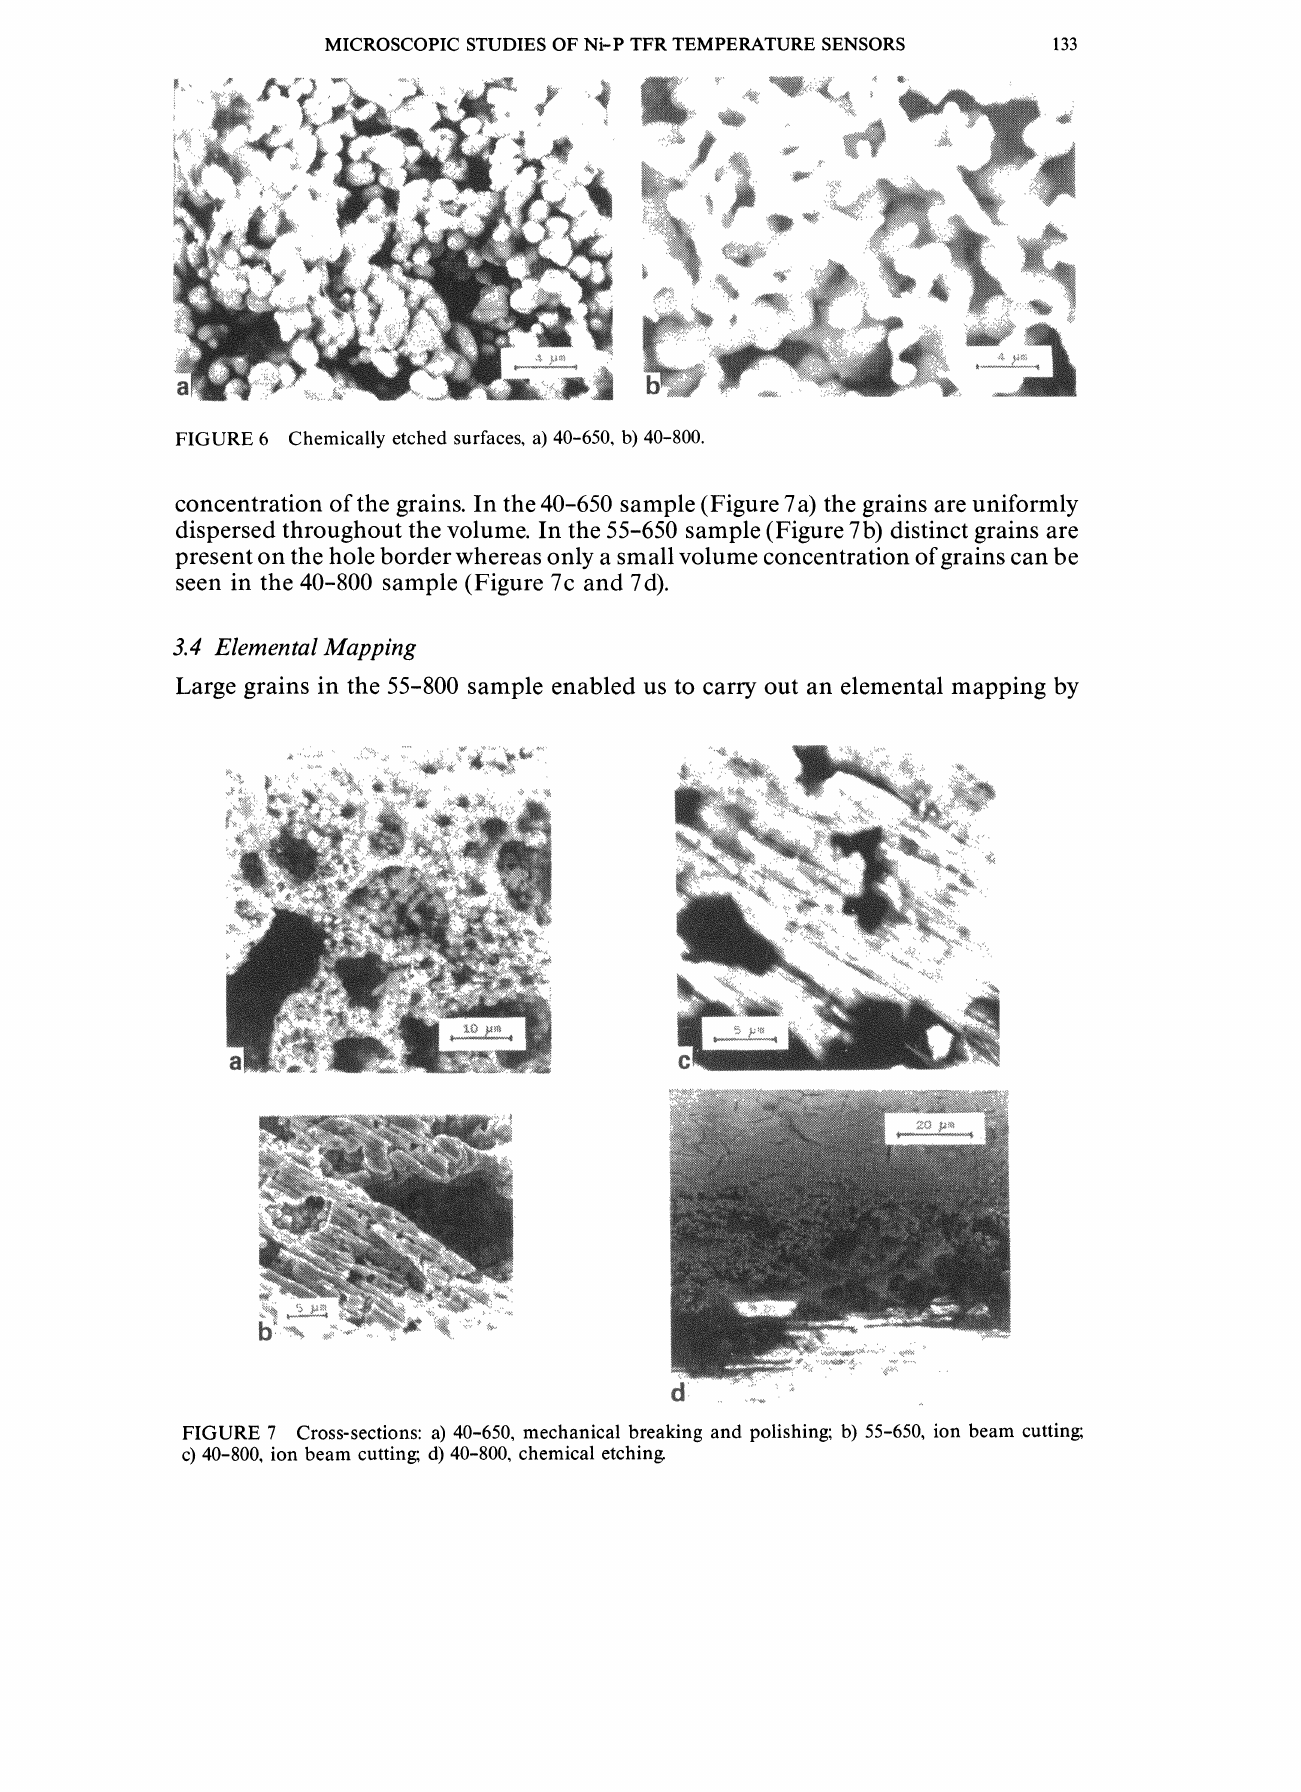
FIGURE 7 Cross-sections: a) 40-650, mechanical breaking and polishing; b) 55-650, ion beam cutting; c) 40-800, ion beam cutting; d) 40-800, chemical